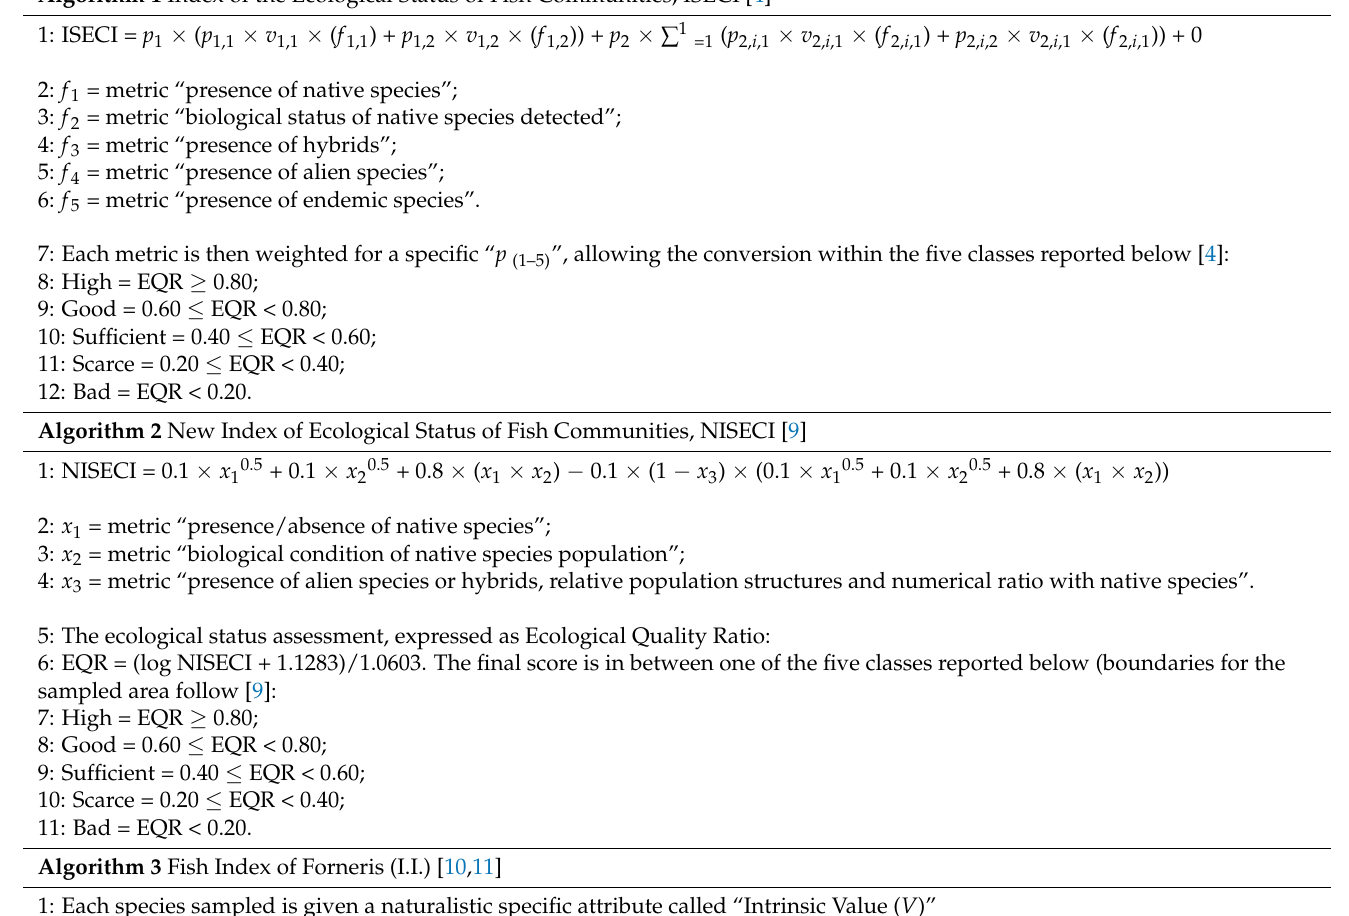
Table 1. Algorithms applied in the three indices used to rate the quality class of the fish community. Algorithm 1 Index of the Ecological Status of Fish Communities, ISECI [4]